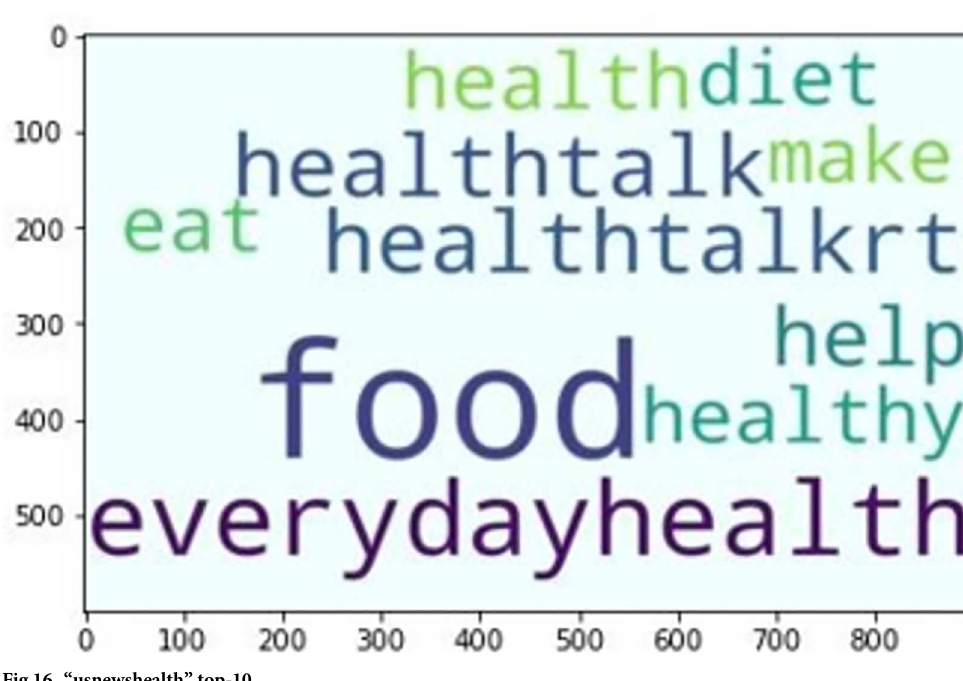
Fig 16. “usnewshealth”